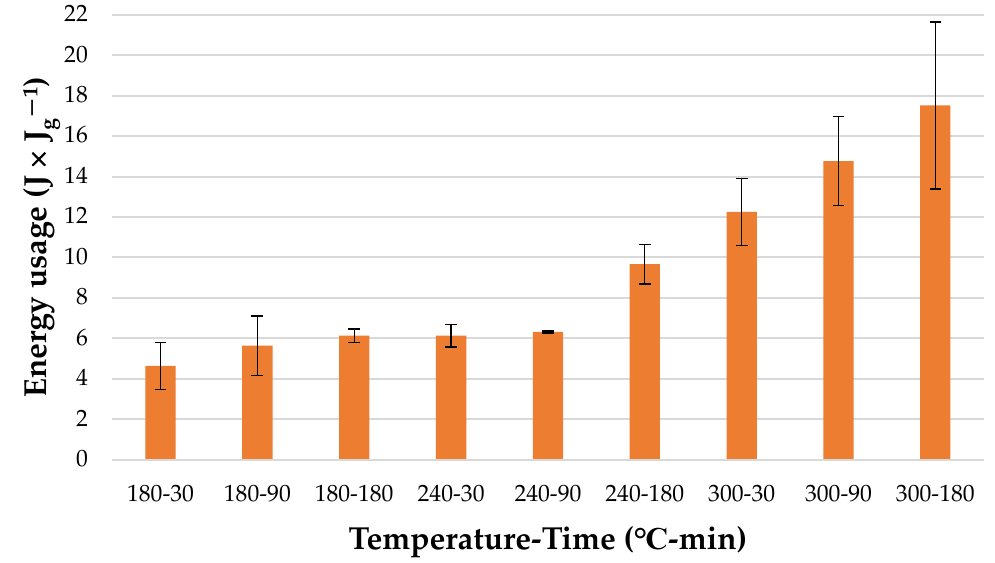
Figure 8. Energy usage in relation to one unit of energy available in one unit of obtained dry HC . (300 ◦ C, 180 min) (17.52 ± 4.12 J × J g − 1 ). Moreover, the analysis of variance showed that